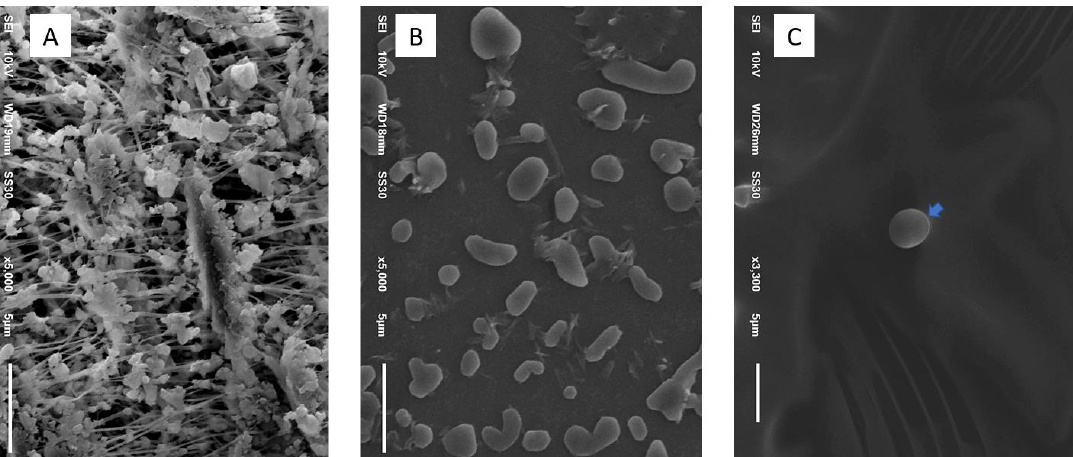
Figure 3. Appearance of PM 2.5 by scanning electron microscopy from filter paper ( A ), PM 2.5 extracted solution ( B ), and the abdominal body parts of a mosquito ( C ).